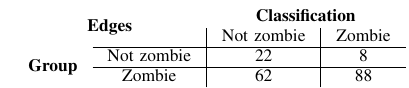
TABLE III: FACE RECOGNITION RESULTS WITH EDGES.